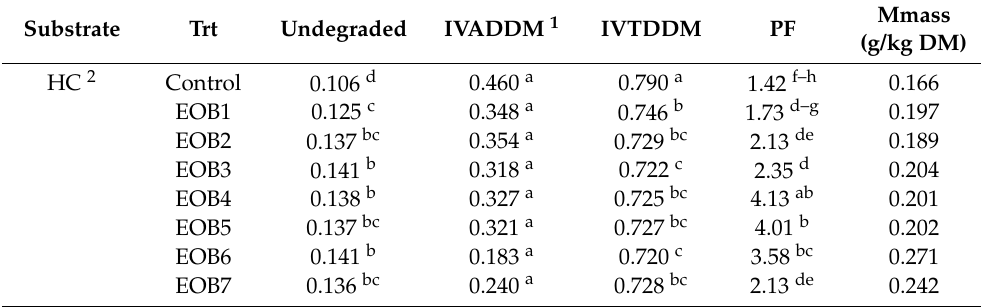
Table 2. Effects of the essential oil blends (EOBs) and substrates on some fermentation parameters ( n =